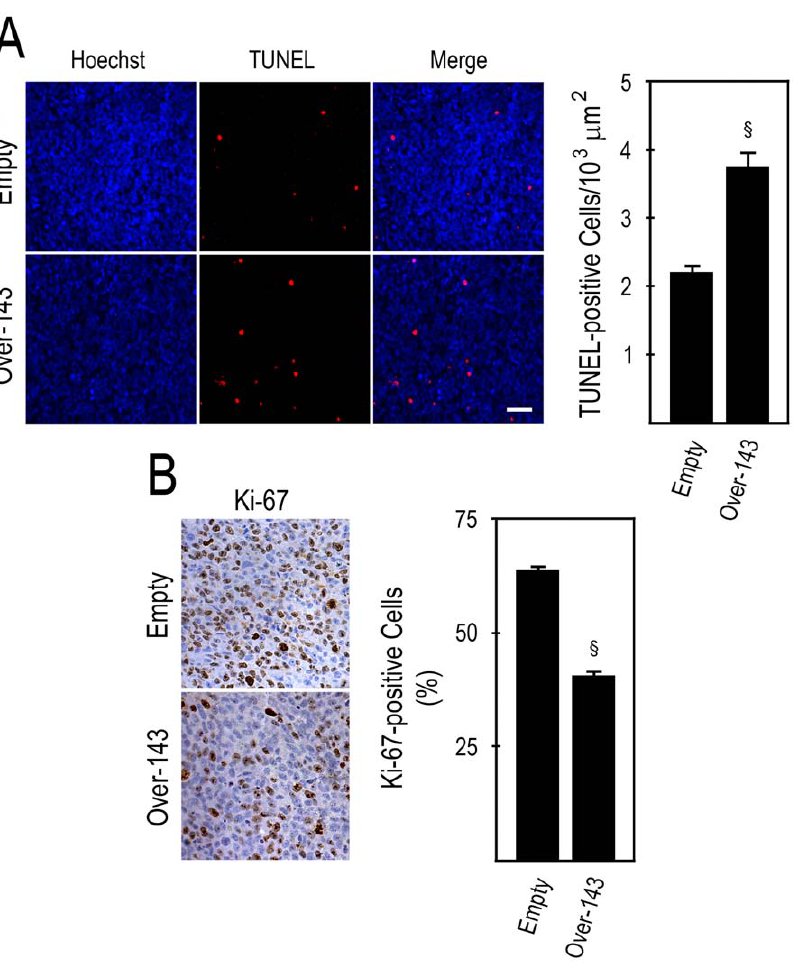
Figure. 6. miR-143 overexpression increases apoptosis and decreases proliferation in tumor xenografts. Tumor xenografts obtained by s.c. injection of Over-143 or Empty cells were formalin fixed and paraffin embedded. Four and 3- m m-thick sections were cut and used for TUNEL assay and Ki-67 immunohistochemistry, respectively. A, Analysis of in situ detection of apoptotic cells in tumor sections of Over-143 and Empty xenografts. Representative images of TUNEL assay (100x) (left panel), and number of TUNEL-positive cells (right panel) of Over-143 and Empty xenografts. B, Analysis of cell proliferation by Ki-67 immunostaining in tumor sections of Over-143 and Empty xenografts. Representative images of Ki-67 immunostaining (400x) (left panel), and percentage of Ki-67-positive cells (right panel) of Over-143 and Empty xenografts. Results are expressed as mean 6 SEM. 1 p , 0.01 from Empty .